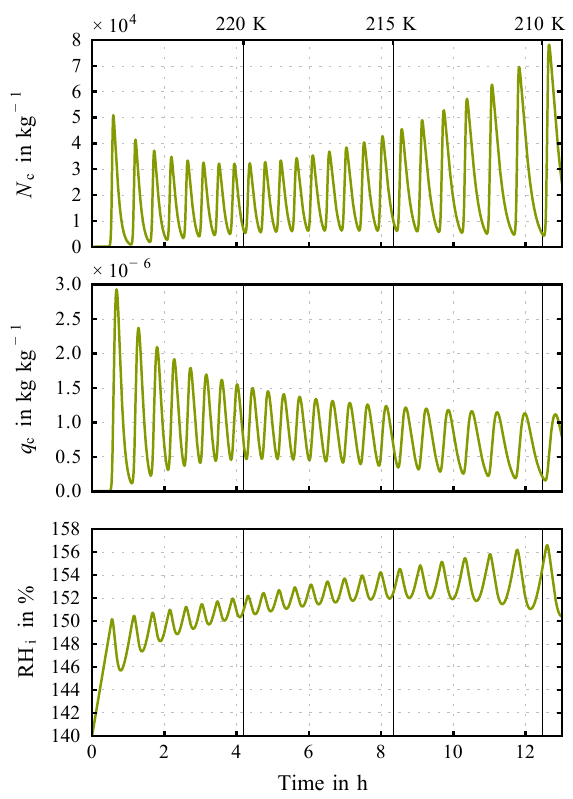
Figure 15. Transition between stable focus regime (state 1) and limit cycle regime (state 2): simulation with the complex model by Spichtinger and Gierens (2009) for w = 0 . 035ms − 1 and start tem- perature: T = 225K. During the first 2h of the simulation, the sink property can be clearly seen. After reaching temperatures of about T ∼ 220K, the regime changes from state 1 (stable focus) to state 2 (limit cycle); see also phase diagram in Fig. 7. After this transition, the amplitudes of number concentrations and relative humidity with respect to ice increase and at the end of the simulation also a shift in the oscillation period can be seen. Increase in amplitude and shift in oscillation period are due to changes of the limit cycle properties for decreasing temperature (see e.g. Fig.